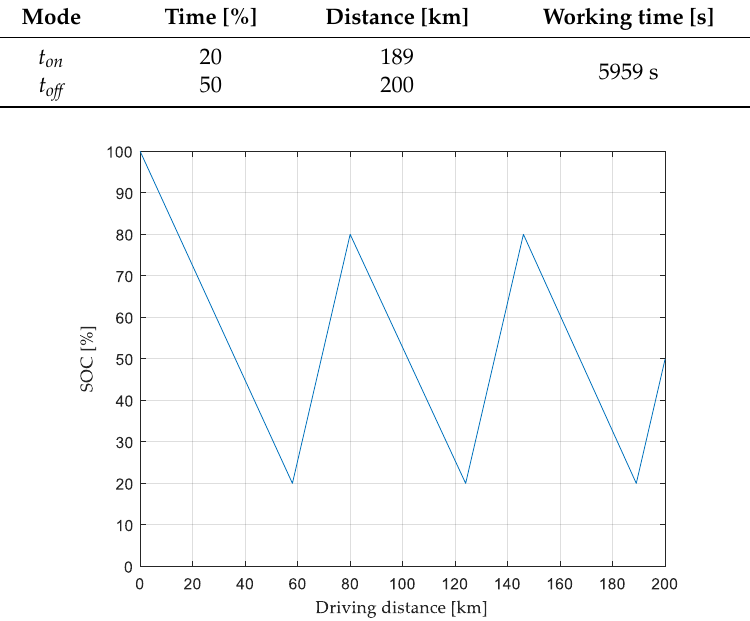
Figure 7. Battery volume of the electric vehicle, distance = 200 km.